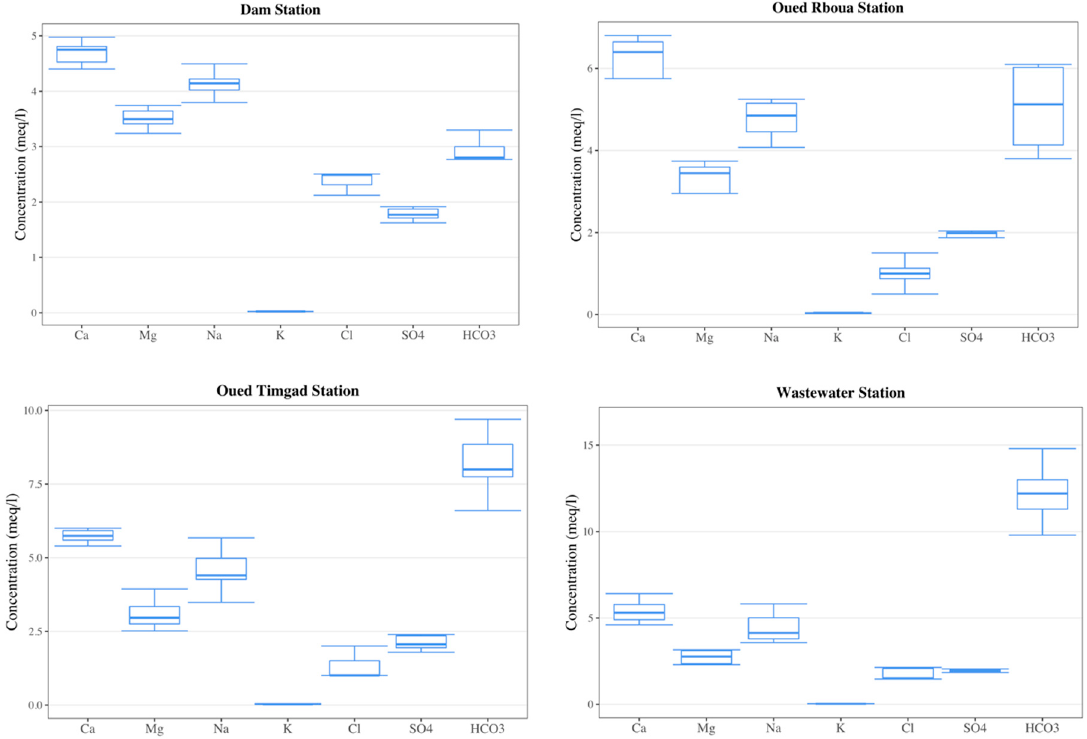
Figure 2. Boxplot of the hydrochemical parameters of the surface water.